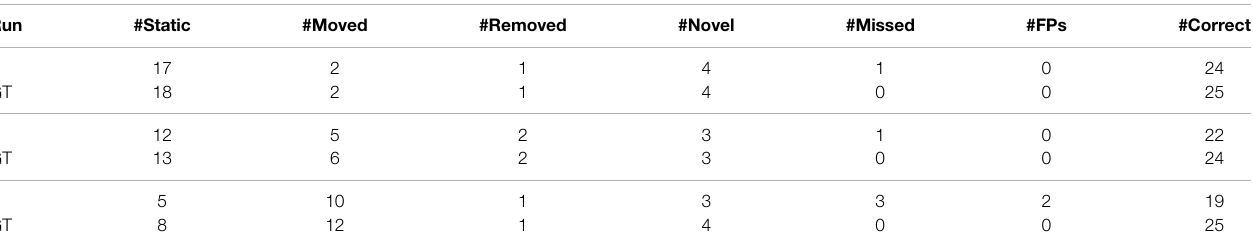
TABLE 5 | Results of matching objects from the robot experiments. The rows with GT refer to ground truth for the respective runs 1 to 3.